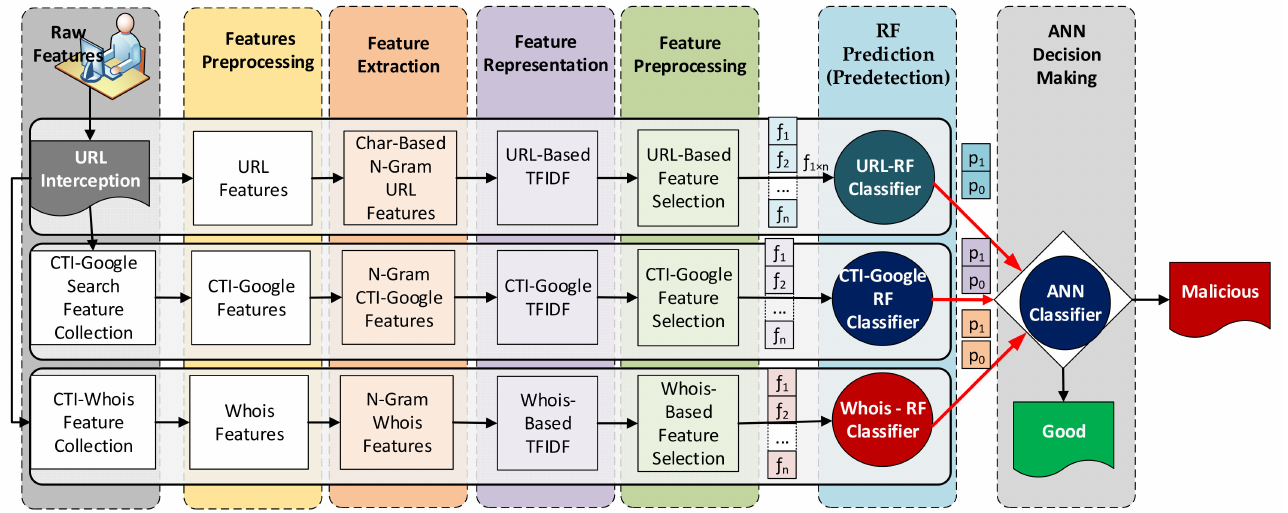
Figure 1. The proposed CTI-MURLD